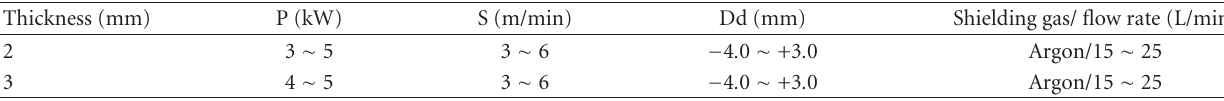
Table 2: Laser welding parameters.